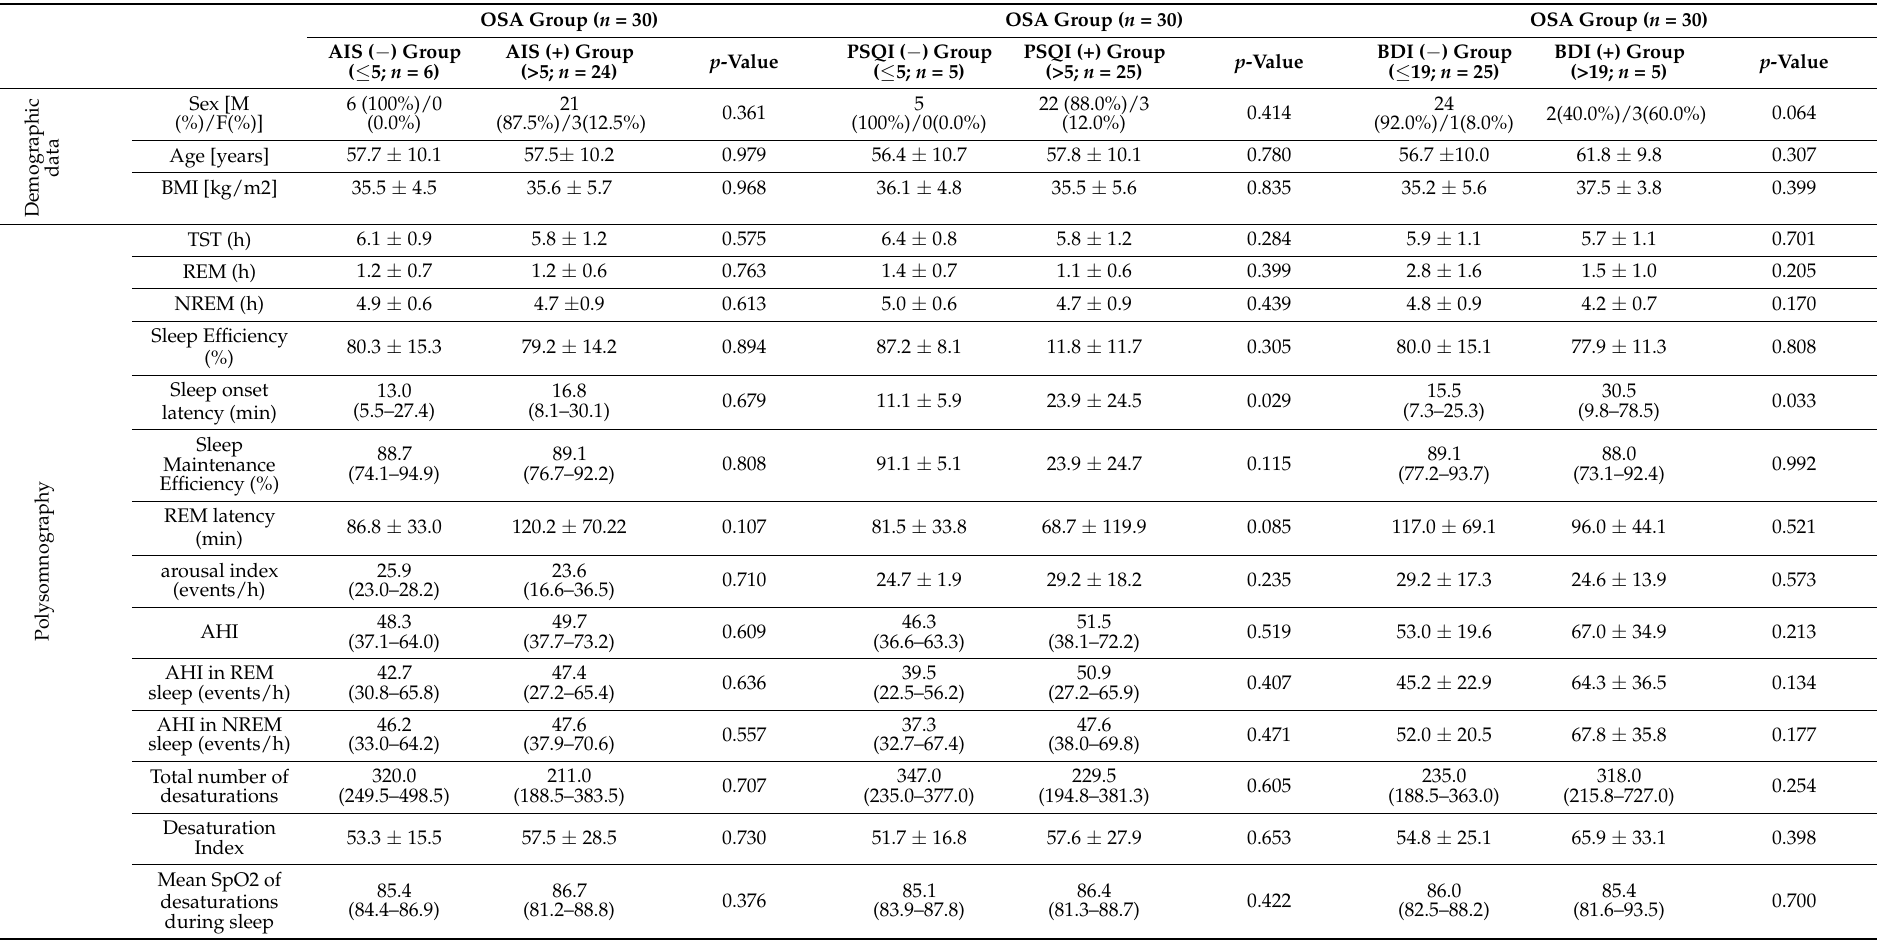
Table 2. Baseline characteristics of the study